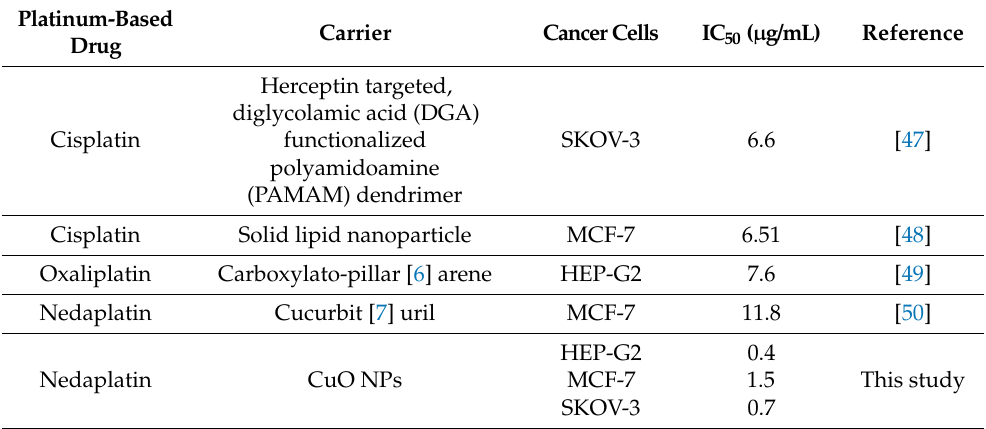
Table 3. Comparison of different Pt-based drugs encapsulated in various carriers against different cancer cell lines.